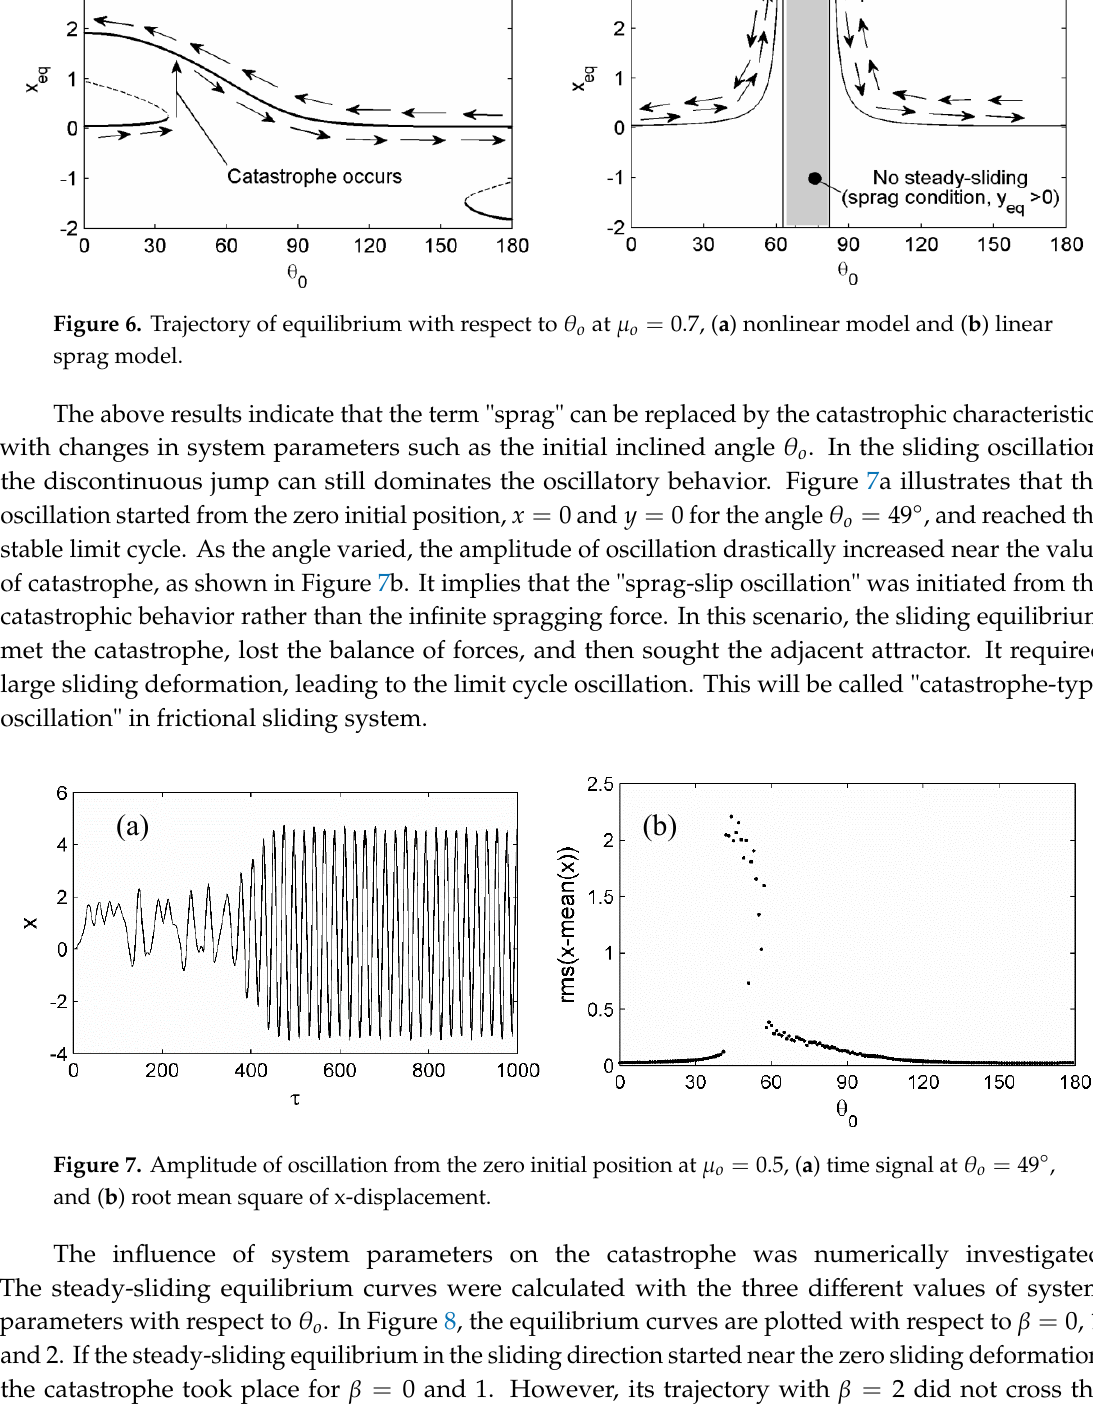
Figure 5. Equilibrium curves with respect to